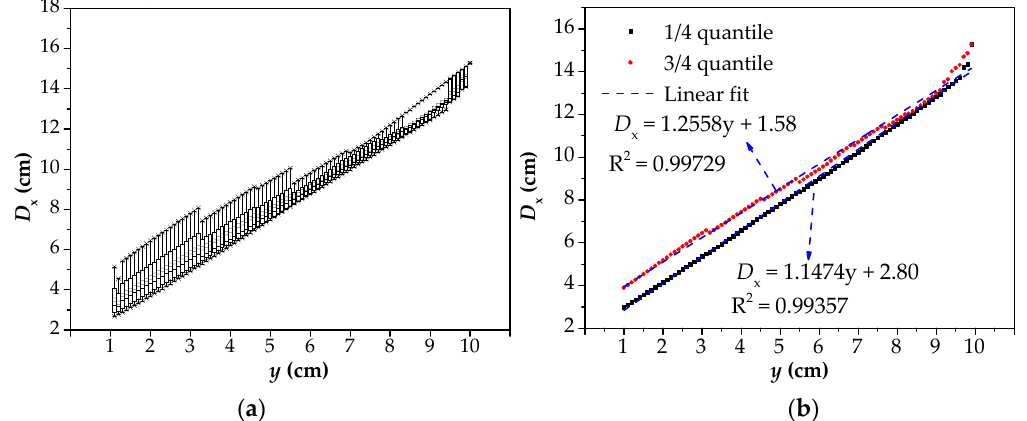
Figure 14. The data processing method: ( a ) the box diagram obtained after data processing; ( b ) Linear fitting of 1 / 4 and 3 / 4 quantiles. D x : the intersecting point distance between curves of magnetic flux component of x direction at different lift off heights; y : the lift off height; R 2 : goodness of fit.